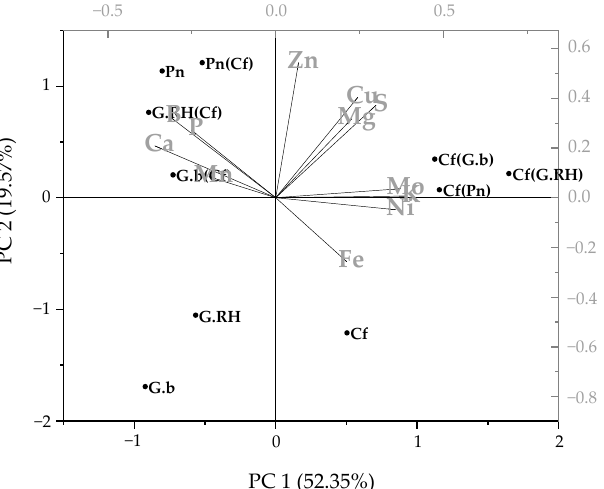
Figure 5. Principal Components Analysis describing foliar nutrient concentration data for each of the protea species (Gb, Grevillea barklyana ; Protea neriifolia , Pn; Grevillea Robin Hood, G.RH) growing alone or with Dactylis glomerata (cocksfoot, Cf), and for cocksfoot growing alone or with each of the proteas. Abbreviations in brackets indicate the companion species.